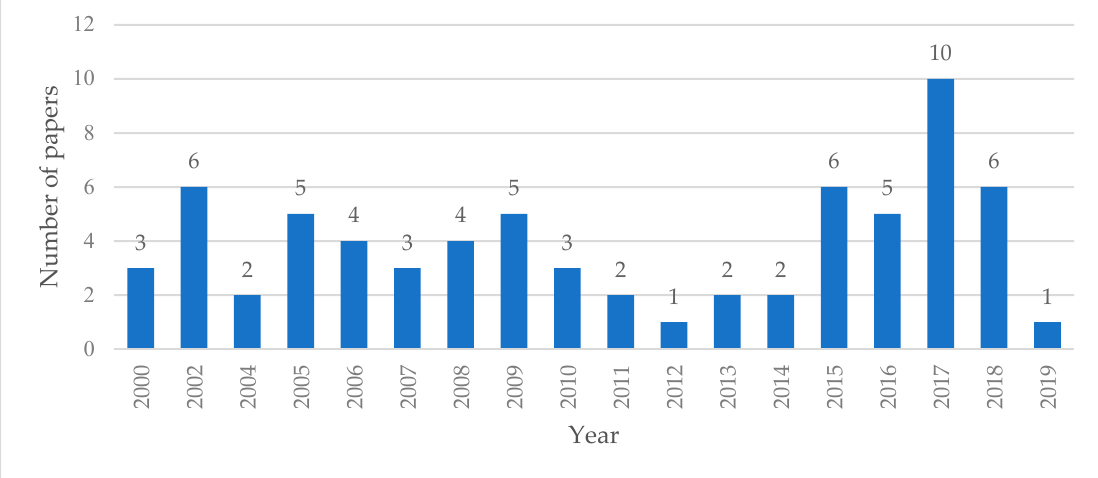
Figure 3. Yearly CTS publications.